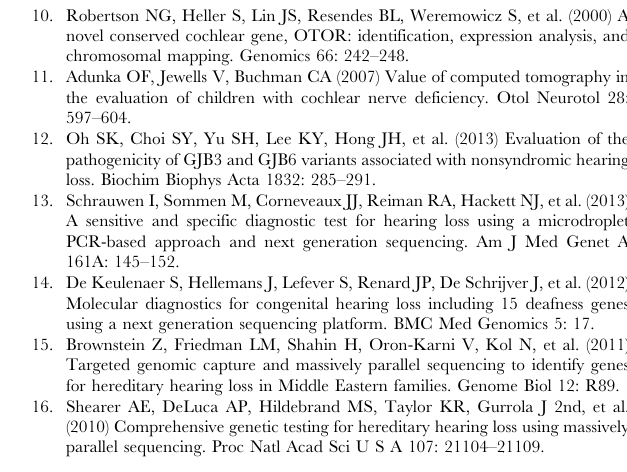
Table S1 Primer sequences used for PCR-Sanger sequencing. Table S2 List of 80 genes related to NSHL for targeted resequencing. Table S3 Qualities of targeted resequencing in 20 familial